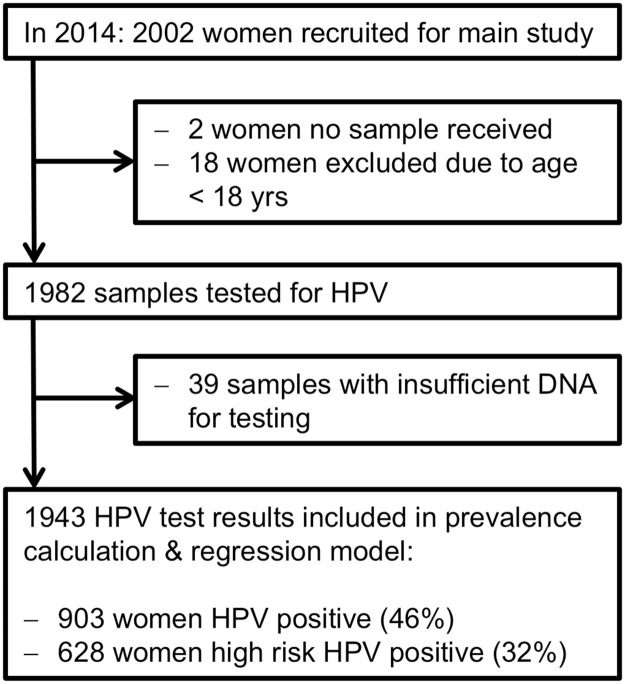
Flow chart of ACCESSING main HPV screening study in 2014.